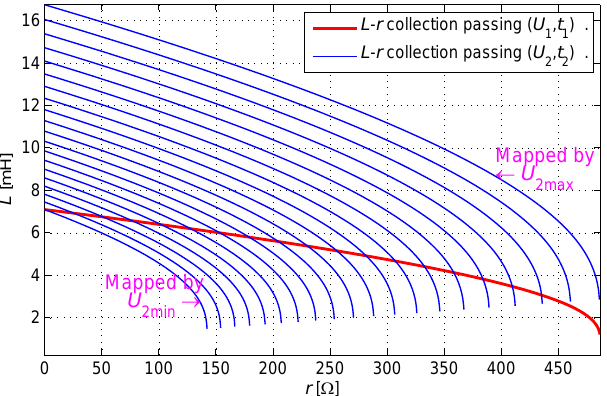
Figure 8. Cluster of curves mapped by U 2 , which have positive real intersections with a given curve mapped by U 1